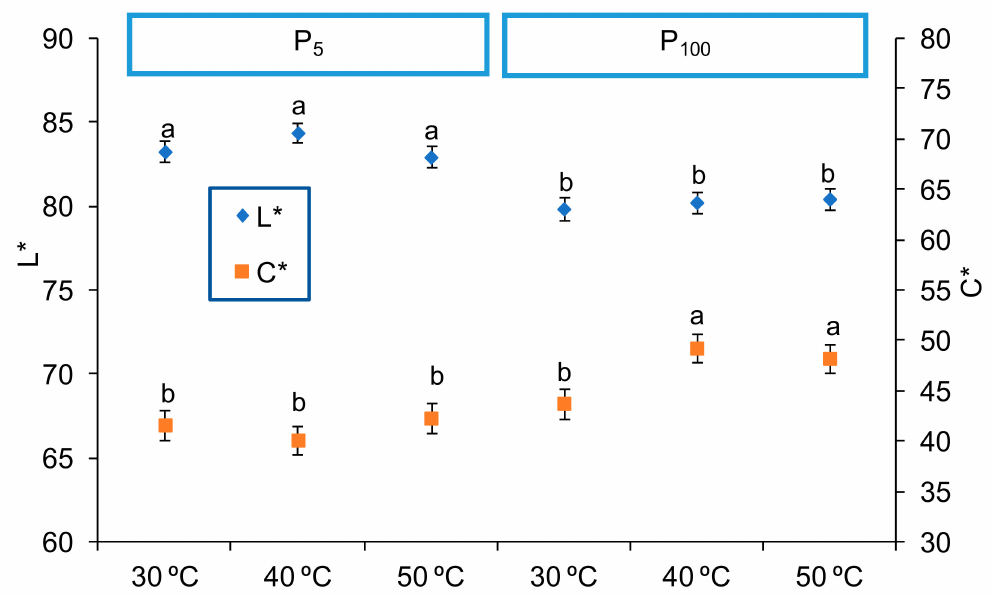
Figure 2. Values (mean and Tukey’s HSD) of L* in left axis and C* in right axis of the freeze-dried purees according to the interaction between shelf temperature (30, 40 or 50 ◦ C) and pressure (P 5 : 5 Pa and P 100 : 100 Pa) factors. Di ff erent letters for each attribute indicate di ff erent homogeneous groups for the Temperature*Pressure interaction ( p < 0.05). Data of both freezing rates are considered in the mean